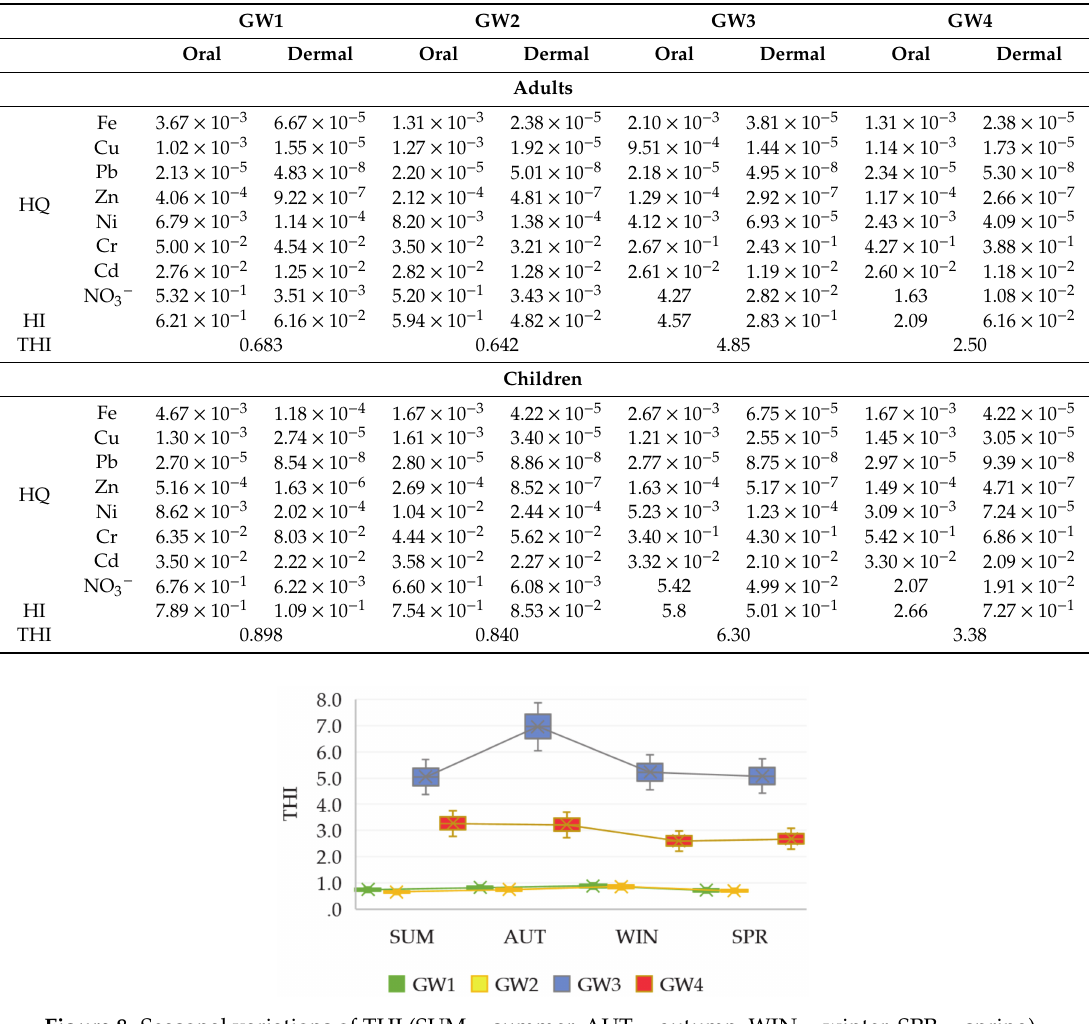
Figure 8. Seasonal variations of THI (SUM = summer, AUT = autumn, WIN = winter, SPR =